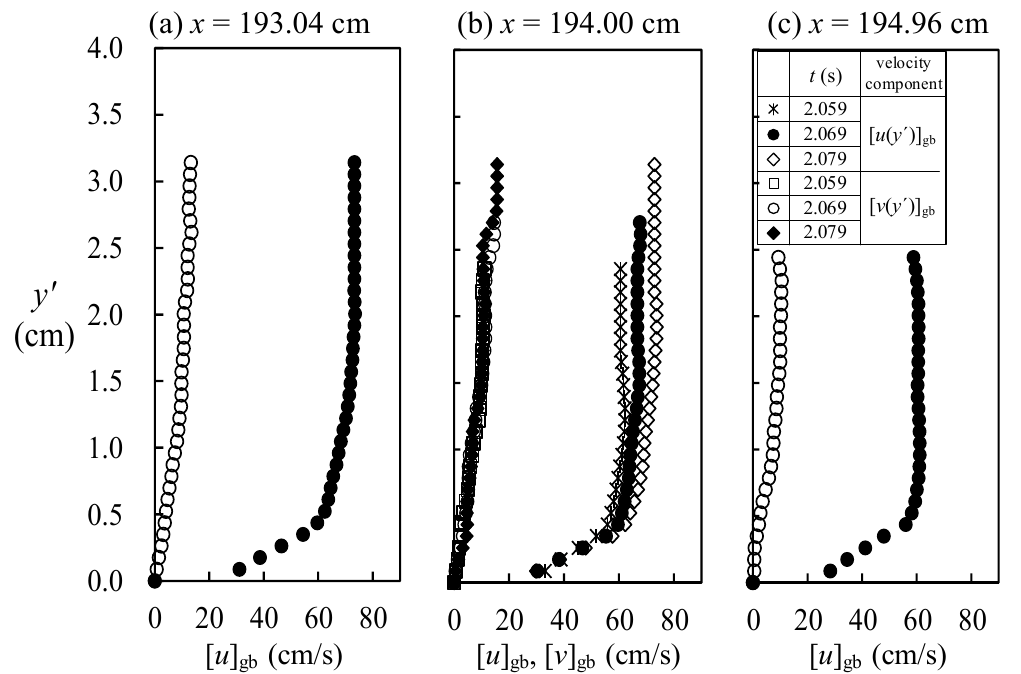
Figure 16. Velocity profiles, [ u ( y ′ )] gb and [ v ( y ′ )] gb , obtained for ( a , c ) t = 2.069 s at x = 193.04 and 194.96 cm; ( b ) t = 2.059, 2.069, and 2.079 s at SMS.